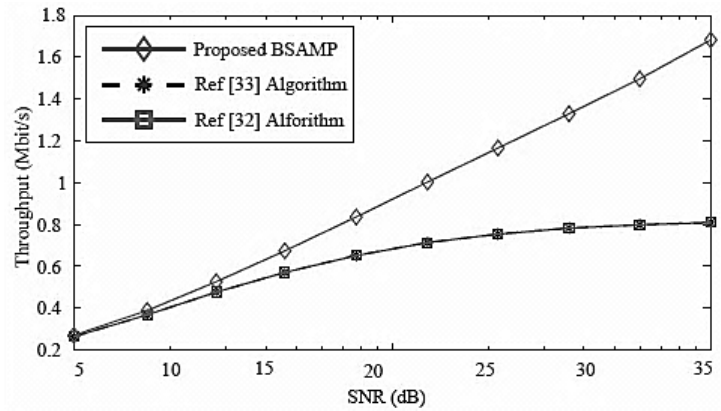
Figure 4. Throughput comparison of each algorithm with increasing SNR.